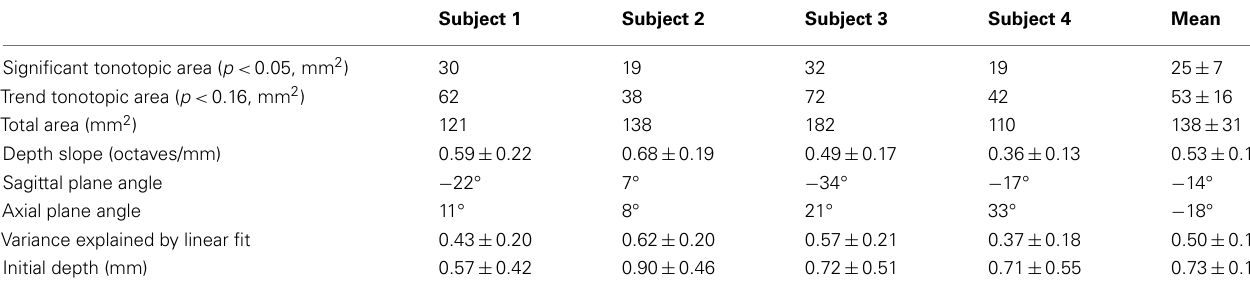
Table 1 | Summary of quantitative results from the tonotopic depth analysis